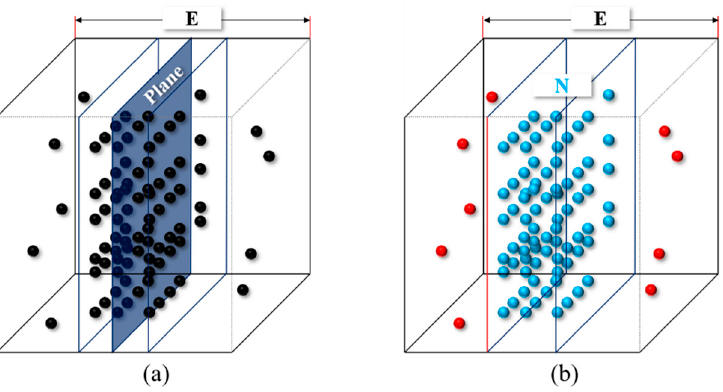
Figure 8. ( a ) Point in voxel; ( b ) Selected point colored by blue and noise colored by red.